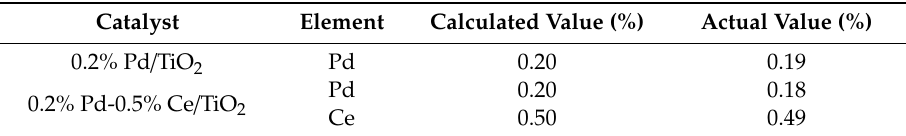
Table 1. Analytical content result of the catalysts.